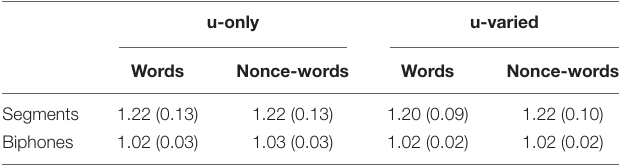
TABLE 5 | Mean phonotactic probabilities (and standard deviations) of words and nonce-words. u-only u-varied